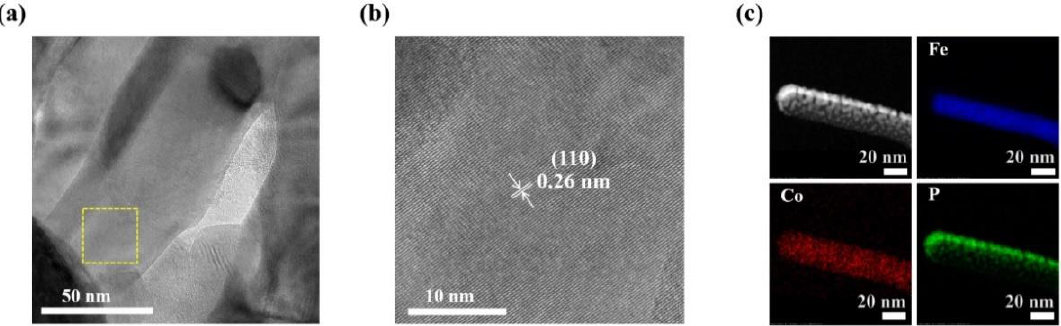
Figure 3. ( a ) Low-resolution transmission electron microscopy (TEM) image of the Fe 2 O 3 nanorod. ( b ) High-resolution TEM image of the dashed yellow square in ( a ). ( c ) TEM-energy dispersive spec- troscopy (EDS) mapping images of Fe 2 O 3 /Co – Pi.